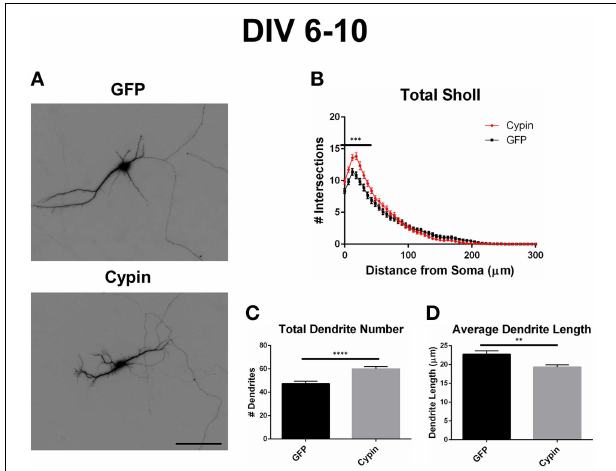
FIGURE 2 | Overexpression of cypin from DIV 6–10 increases proximal branching and total dendrite number but decreases average dendrite length. (A) Representative images of hippocampal neurons overexpressing GFP or GFP-cypin (cypin) from DIV 6–10. Scale bar = 100 µ m. (B) Sholl analysis of all orders of branches (Total Sholl) shows that overexpression of cypin significantly increases dendrite branching at 0–42 µ m from the cell body ( *** p < 0 . 001 ). Statistics were calculated using Two-Way ANOVA followed by Bonferroni multiple comparisons test. (C) Overexpression of cypin results in a significant increase in the total number of dendrites ( **** p < 0 . 0001 ). Total number of dendrites represents sum of all dendrites, regardless to what category they belong. Statistics were calculated by unpaired, two-tailed Student’s t -test. (D) Overexpression of cypin results in a significant decrease in the average length of dendrites ( ** p < 0 . 001 ). Average length is the mean length of all dendrites, regardless to what category they belong. Statistics were calculated by unpaired, two-tailed Student’s t -test with Welch’s correction. Error bars indicate SEM. n = 50 neurons for GFP, and n = 55 neurons for